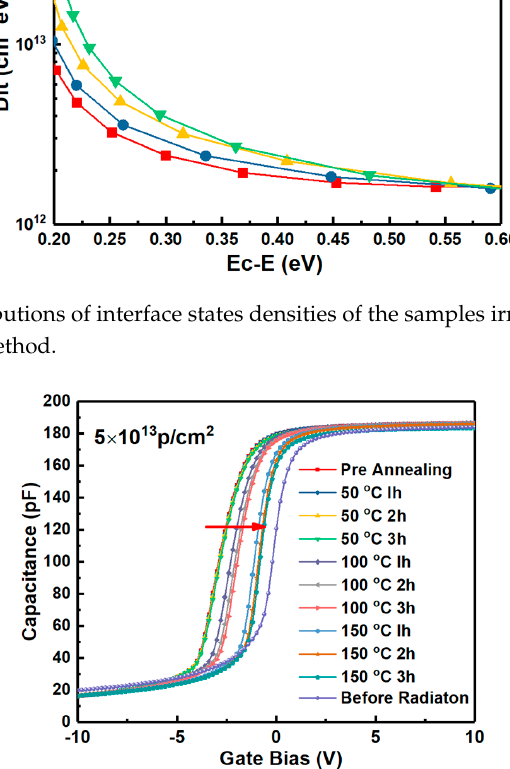
Figure 16. HF C-V characteristics of the samples at di ff erent stages of the isochronal annealing.